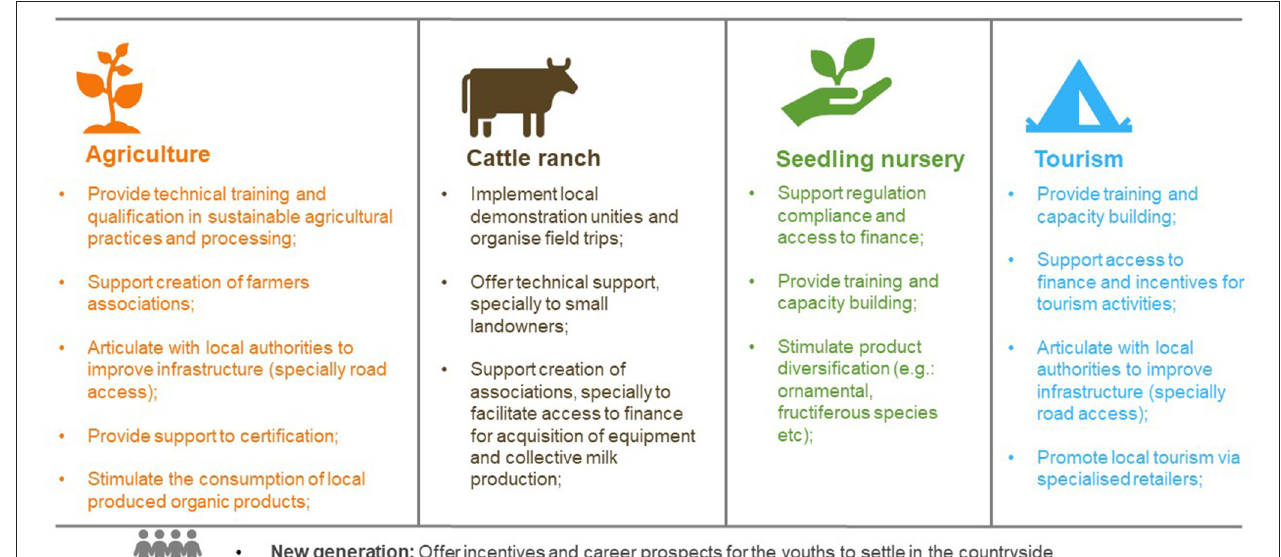
FIGURE 5 | Solutions presented in activity II of the